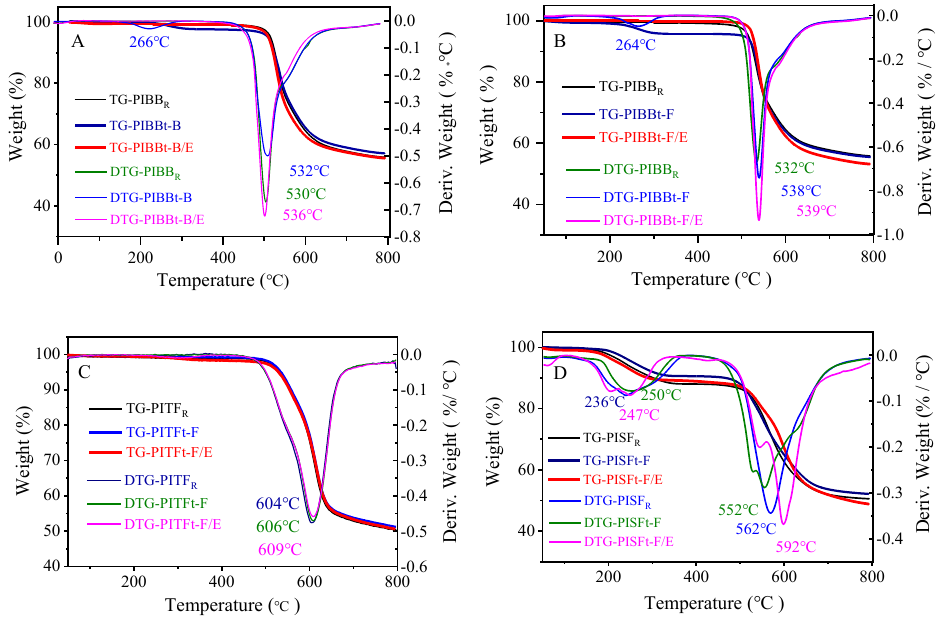
Figure 6. TGA thermograms of CPI films capped with different blockers: ( A ) PIBB R /PIBB t-B /PIBB t-B/E ; ( B ) PIBB R /PIBB t-F /PIBB t-F/E ; ( C ) PITF R /PITF t-F /PITF t-F/E ; and ( D ) PISF R /PISF t-F /PISF t-F/E . The TGA and DTG curves of PIBBs, PITFs, and PISFs can be seen in Figure 6A–D. The 5% weight-loss temperature (T d5% ), 10% weight-loss temperature (T d10% ), and residual carbon contents at 780 °C (R w780 ) are shown in Figure 7A-7D. All PIBBs show good thermal stability with T d5% at 503-525 °C, T d10% at 522-533 °C, and even at 780 °C, thermogravimetry is above 53%. PIBB t-B capped with BPDA shows a 2.2% lower weight-loss than PIBB R and PIBB t-B/E , while the PIBB t-F capped with 6FDA shows 4.0% less weight-loss than PIBB R and PIBB t-F/E (Figure 7A,B). The differences in thermal stability are due to small molecule evaporation or anhydride group decomposition at 200-300 °C. On the other hand, the blocker EG increases PAA molecular weight by coupling. The thermal stability of PIBB t- B/E and PIBB t-F/E are both higher than PIBB t-B and PIBB t-F under the pyrolysis temperature of PIBBs. The decomposition of PIBB t-B and PIBB t-F chains generally appear at lower temperatures than that of PIBB t-B/E and PIBB t-F/E , due to the unstable anhydride groups.